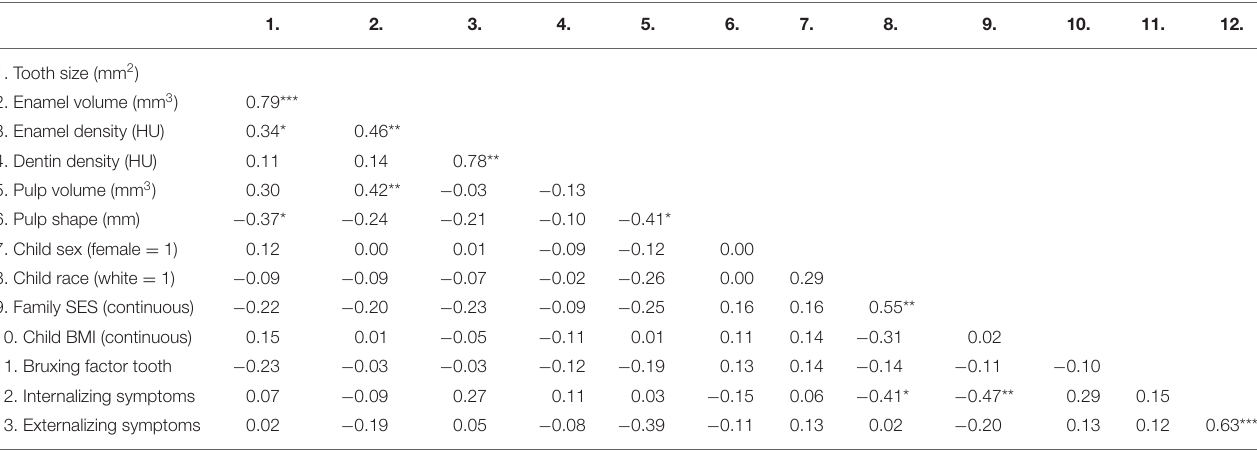
TABLE 2 | Correlations between the six tooth measures, the five possible covariates, and the two outcomes ( n =